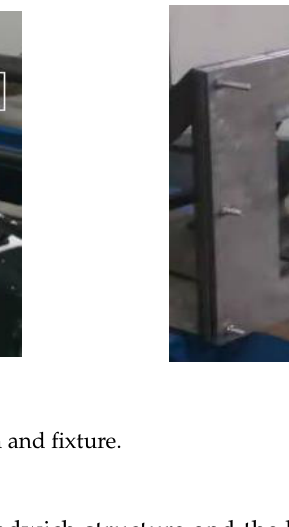
Figure 2. ( a ) Experimental setup; ( b ) Specimen and fixture.